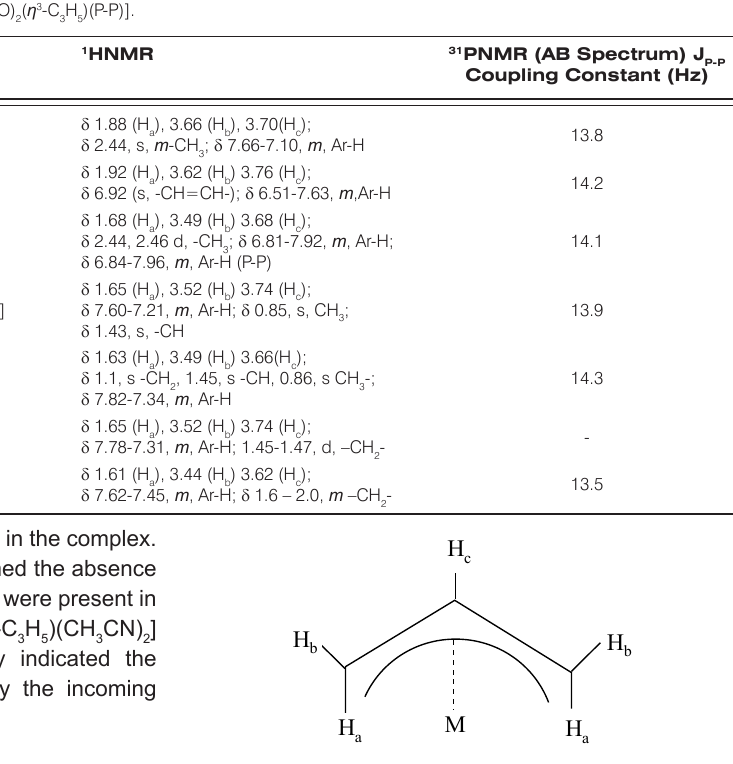
Figure 3. Classification of allyl